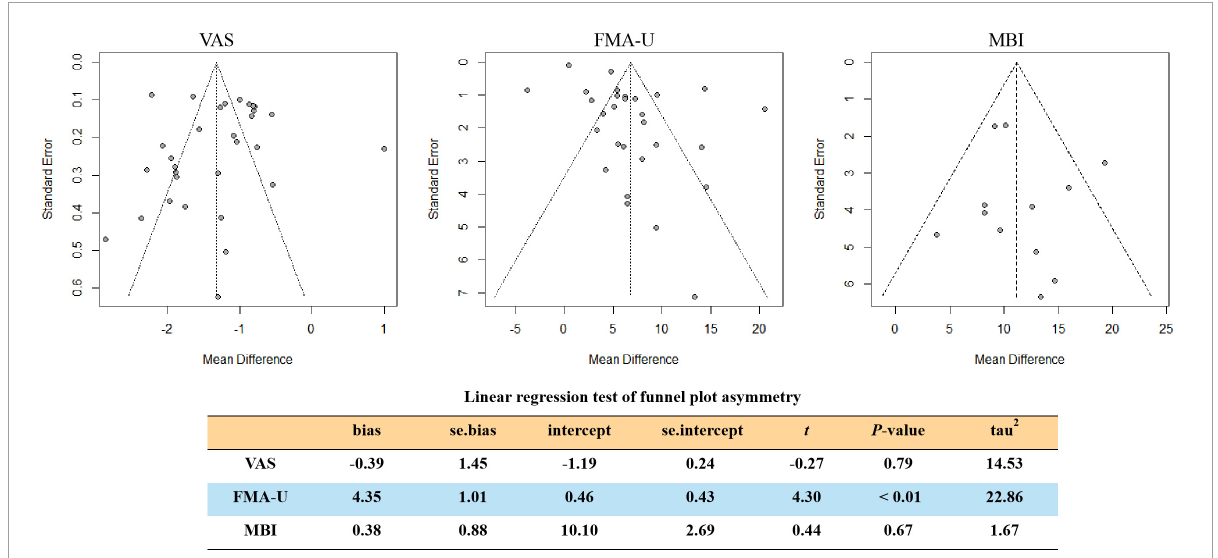
FIGURE9 Funnel plots illustrating meta-analysis of VAS, FMA-U, and MBI. (FMA-U, Fugl-Meyer Assessment Scale for upper extremity; MBI, modified Barthel Index; VAS, visual analog